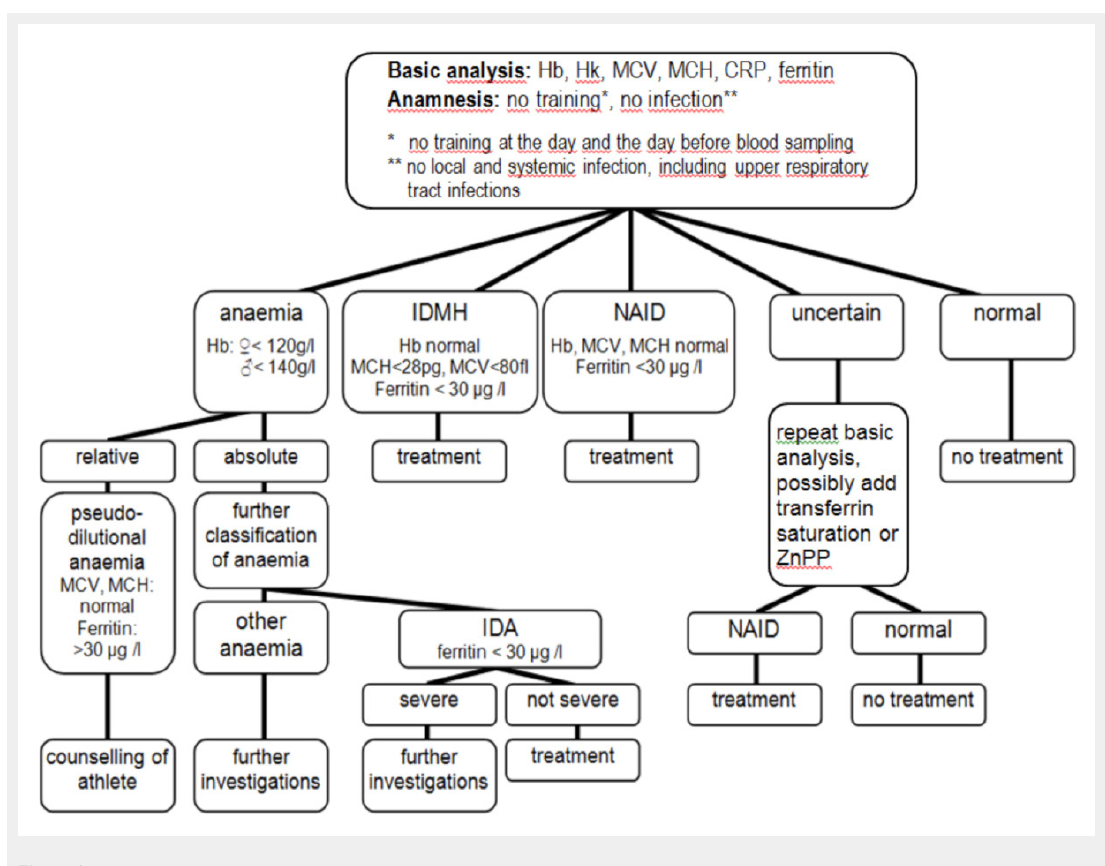
Figure 4 Overview of diagnosis and indications for treatment in adults. CRP = C-reactive protein; Hb = haemoglobin; Hk = haematocrit;IDA =iron deficiency with anaemia; IDMH =iron deficiency with microcytosis and/ or hypochromia; MCH = mean cellular haemoglobin; MCV = mean cellular volume; NAID =nonanaemic iron deficiency; ; ZnPP = zinc